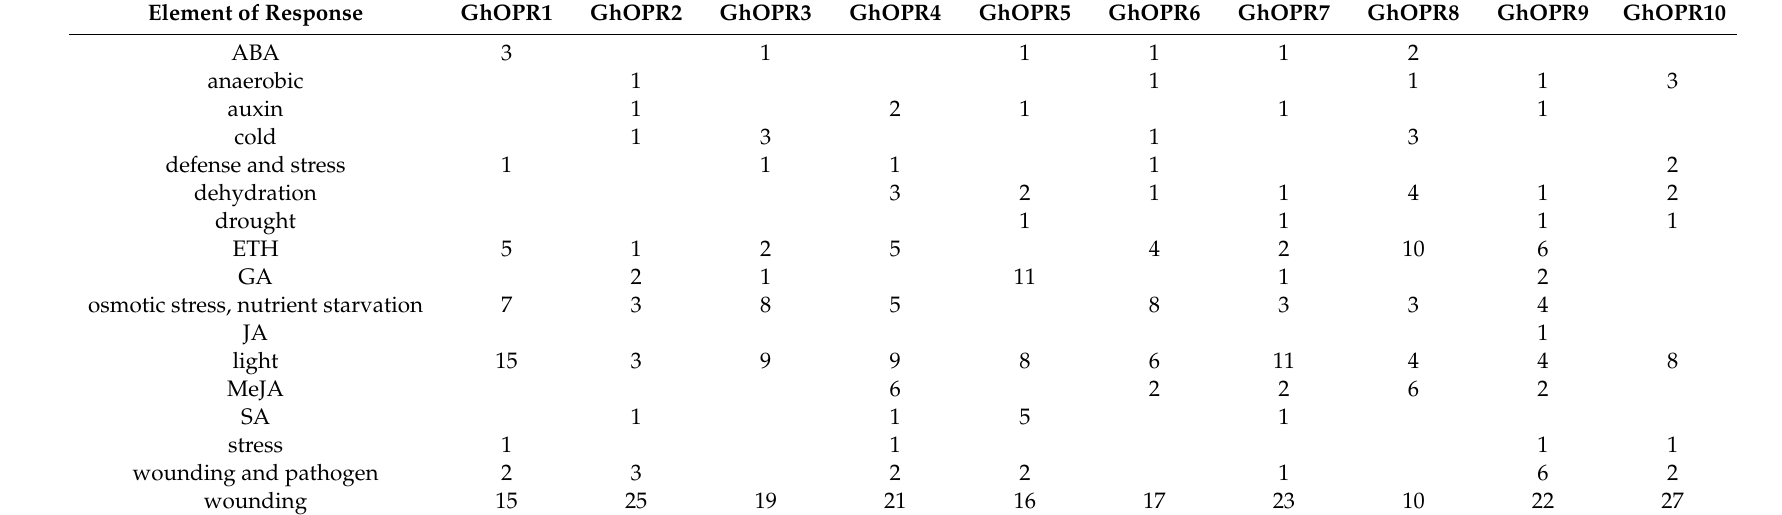
Table 1. Prediction of cis-acting regulatory elements about various responses of GhOPR